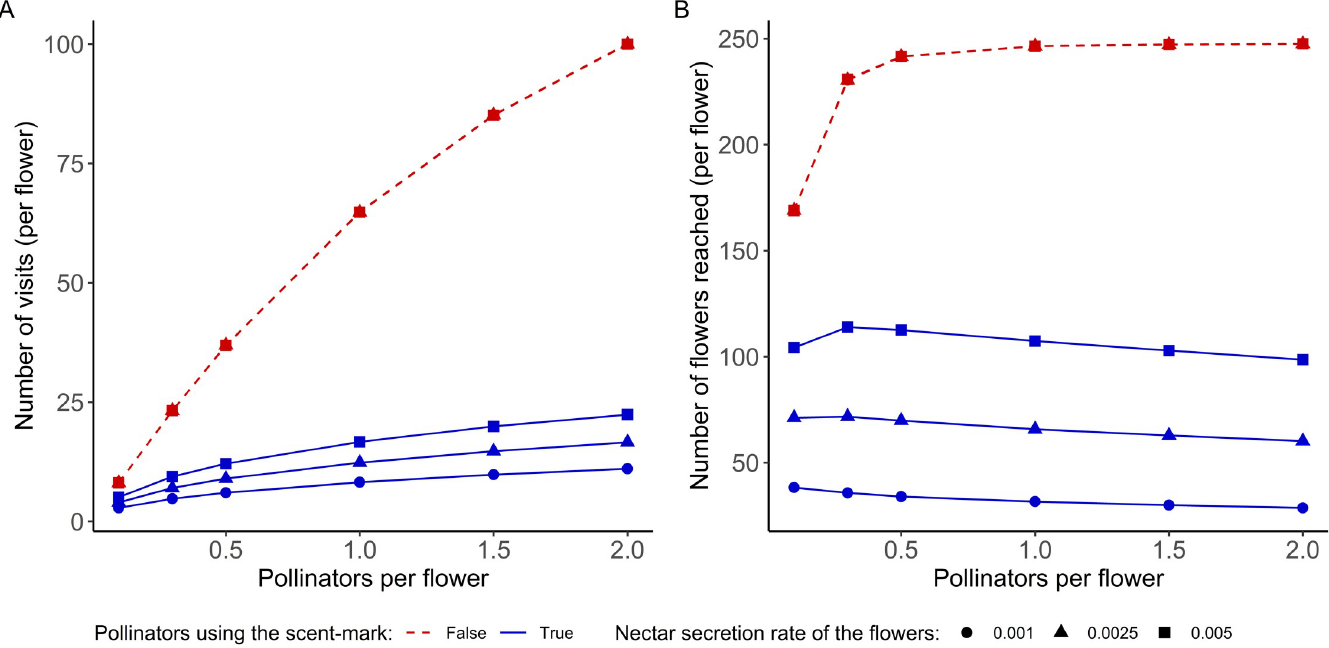
Fig 6. (A) Mean number of visits per flower during the simulation. (B) Mean number of flowers visited by a pollinator after he leaves the focal flower. In each figure, the x-axis represents the relative abundance of pollinators compared to flowers. The effect on the coefficient of variation can be found in the S3 File.